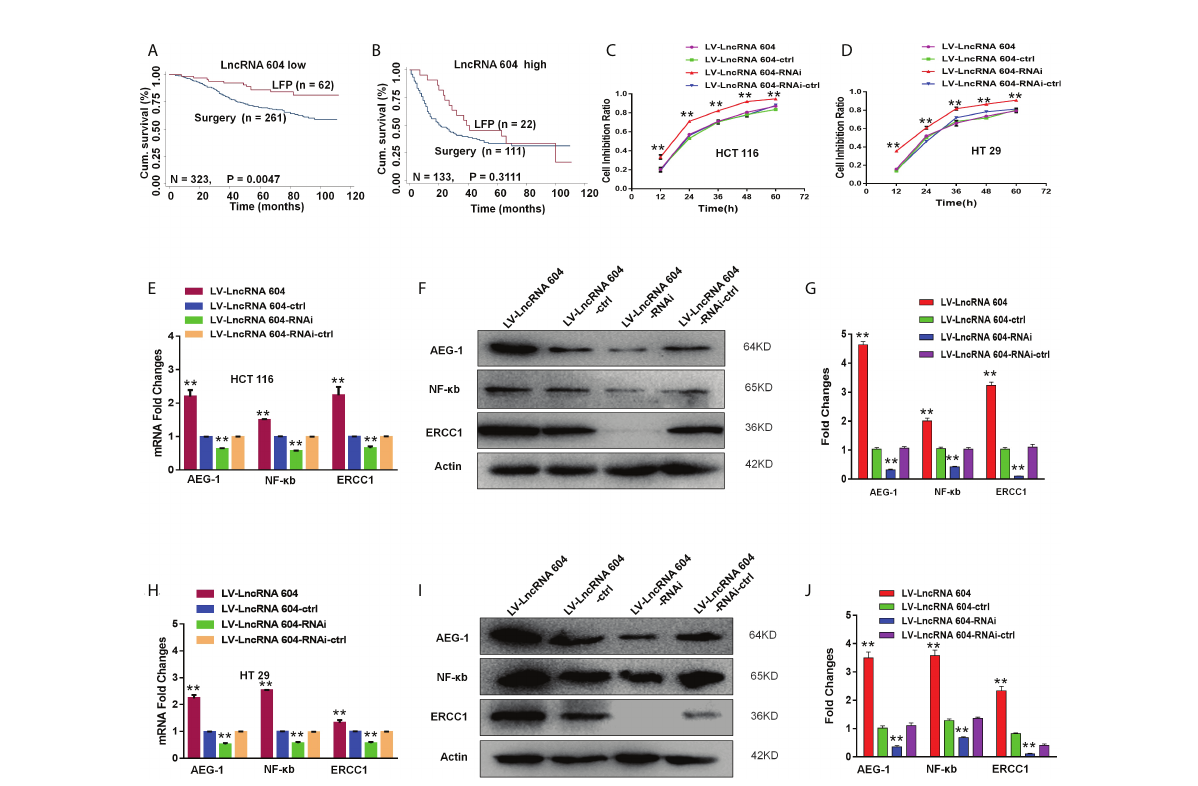
FIGURE 7 LncRNA 604 promoted CRC cell chemoresistance by improving the expression of AEG-1, NF- k b, and ERCC1. (A, B) CRC patients with low- expressed or high-expressed lncRNA 604 who adopted postoperative LFP regimen compared with patients who received surgery alone on OS by Kaplan-Meier curve method (A) low-expressed lncRNA 604; (B) high-expressed lncRNA 604). (C, D) LV-lncRNA 604-RNAi CRC cells were more sensitive than control group, however LV-lncRNA 604 cells were not sensitive by CCK8 assay in vitro (C) HCT 116; (D) HT 29). (E – G) AEG- 1, NF- k b, and ERCC1 in HCT 116 cells were changed with the expression of lncRNA 604 by RT-PCR and WB (E) RNA; (F) , (G) protein). (H – J) AEG-1, NF- k b, and ERCC1 in HCT 29 cells were changed with the expression of lncRNA 604 by RT-PCR and WB (H) RNA; (I) , (J) protein. All ** P <